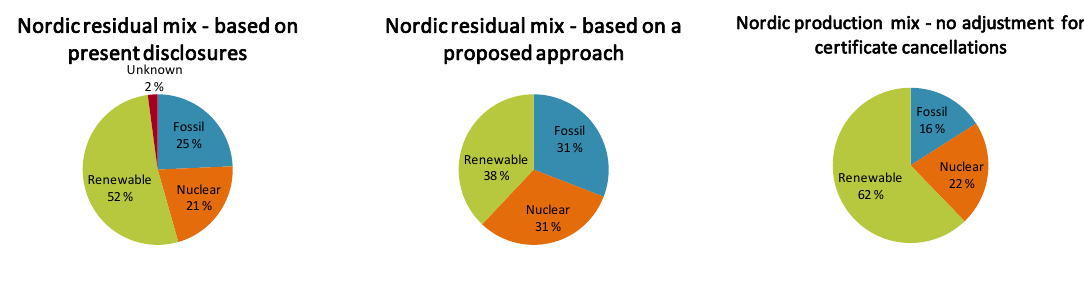
Figure 3. Comparison of a common Nordic residual mix for 2007, based on the present disclosures and an approach proposed by Swedish Elforsk [15], as well as the Nordic production mix for 2007